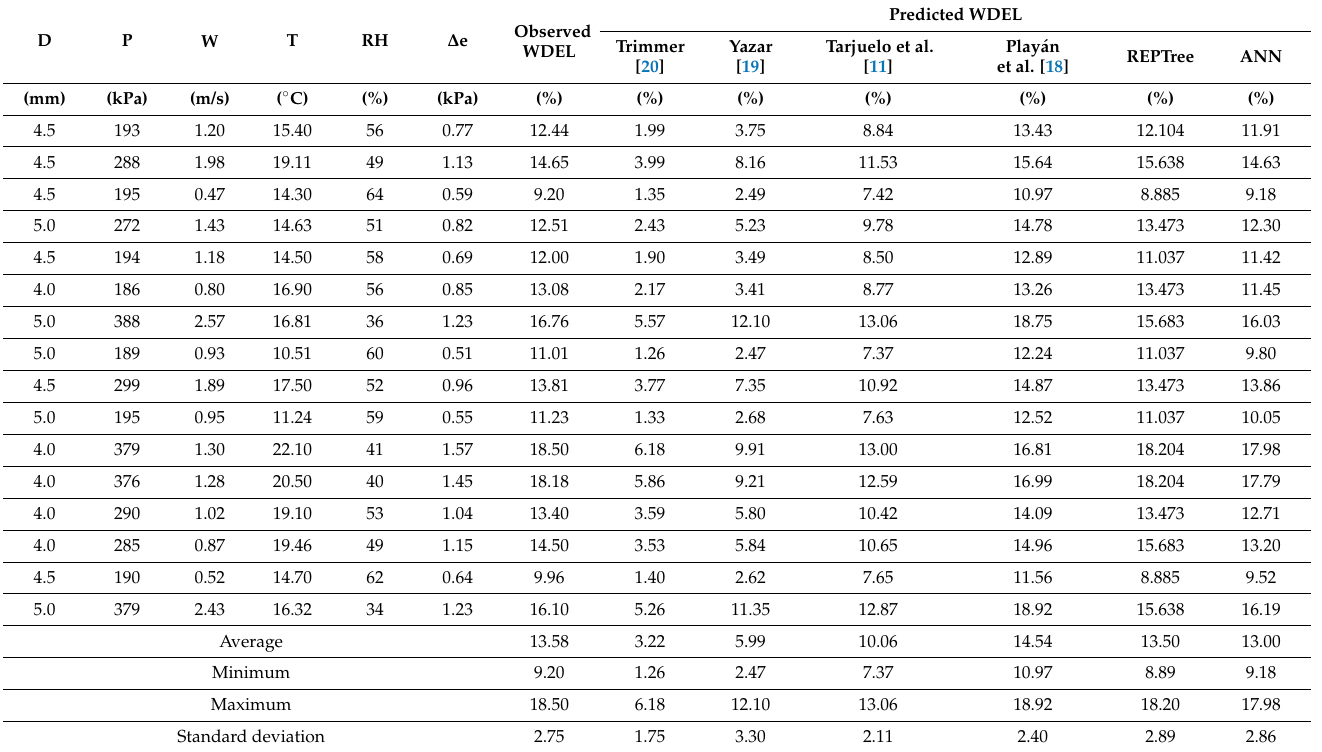
Table 5. Observed and predicted WDEL values using different approaches under various